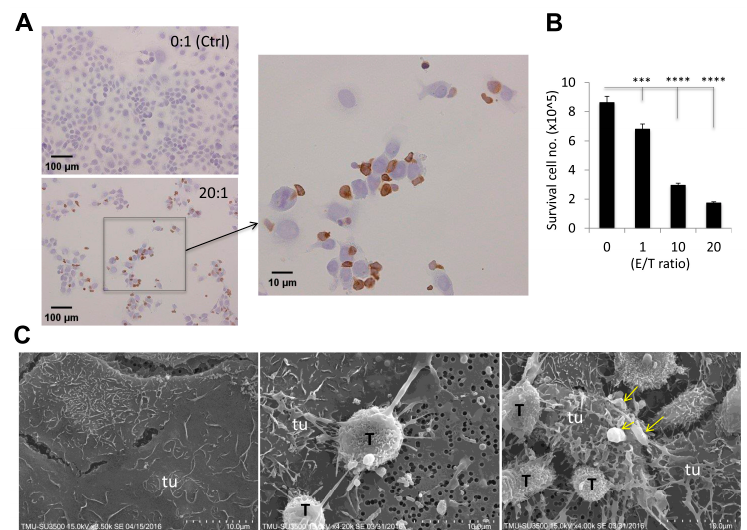
Figure 4. Visualization of γδ -T-cell-attached cytotoxicity towards OVCAR3 cells. γδ -T-cells and OVCAR3 cells were co-cultured at E/T ratios of 0 and 20 on chamber slides. After 24 h, cells were mounted for CD3-IHC staining to illustrate γδ -T-cells (brown color, arrow indicated enlarged area) ( A ), and surviving OVCAR3 cells were counted using light microscopy ( B ). A cytotoxic reaction was carried out with an E/T ratio of 20 in the transwell ( C ), as illustrated by the representative scanning electron microscopic (SEM) images ( × 1000) of γδ -T-cell (T) cytotoxicity-induced morphologic changes (middle and right) of attacked OVCAR3 cells and the teaming up of γδ -T-cells in the attack as shown in A, using control OVCAR3 (tu) cells only (left) for comparison. Yellow arrows indicated cytoplasmic blebbing. (*** p < 0.001; **** p < 0.0001)